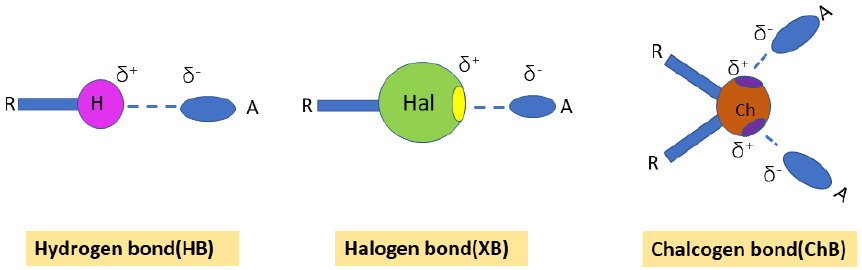
Scheme 1. A simple view of the electrostatic component of hydrogen, halogen, and chalcogen